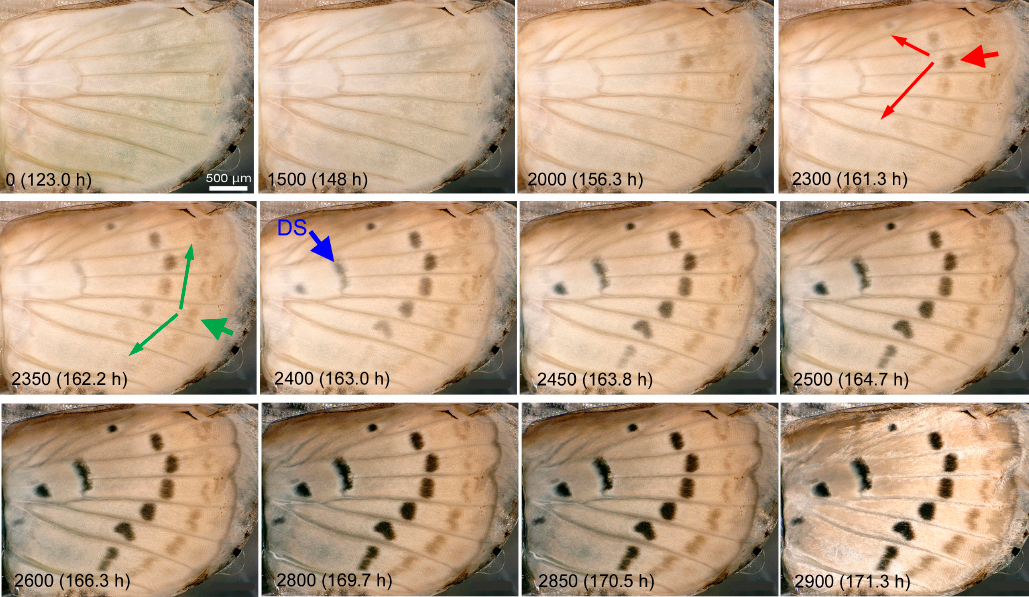
Figure 10. Coloration sequence of the pupal forewing. Images were recorded every 1 min; the image number and postpupation time are shown in each panel. The earliest emerging spot is clearly seen in IN2300 (indicated by a thick red arrow), although it can be seen as early as IN0. This is one of the spots in the third spot array. Gradients of the third spot array are indicated by thin red arrows in the same panel. In the second spot array, a spot in a different compartment emerges first that is indicated by a thick green arrow in IN2350. In the same panel, gradients of the second spot array are indicated by thin green arrows. The discal spot (DS), indicated by a blue arrow in IN2400, emerges later than other spots. See also Video S6.